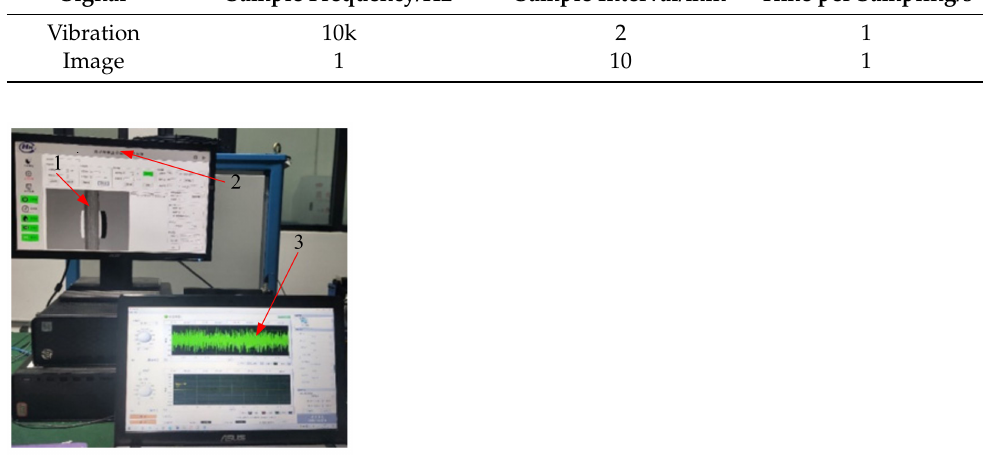
Figure 8. The control interface of the RCF-A test machine. 1. Visual display module; 2. Fatigue test control module; 3. Vibration signal acquisition module.